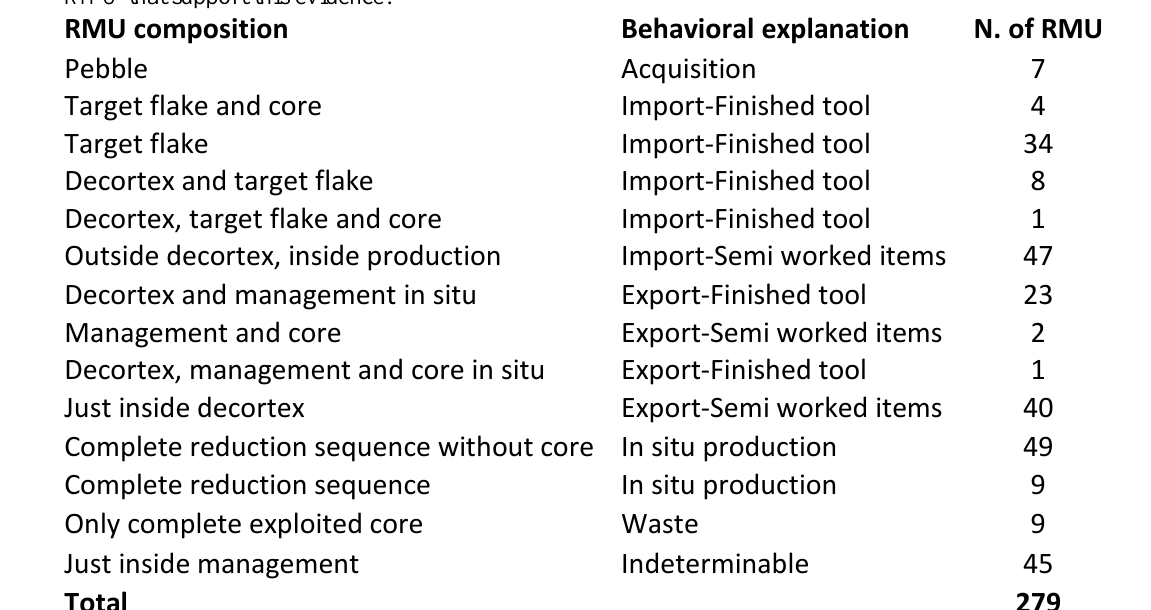
Table 7: Technological composition of RMU, their explanation in terms of human behaviour and number of RMU that support this